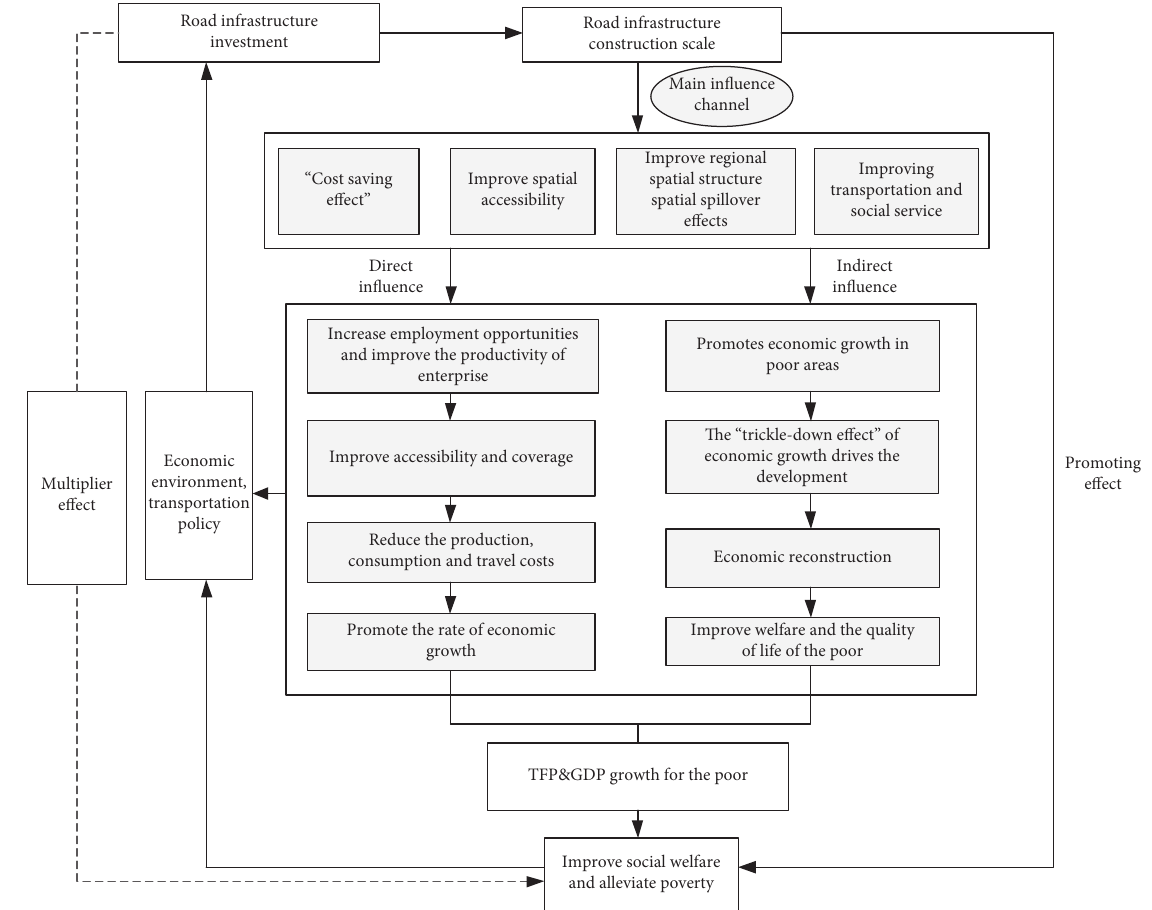
Figure 2: Theoretical framework for the influencing pathway between road infrastructure and local